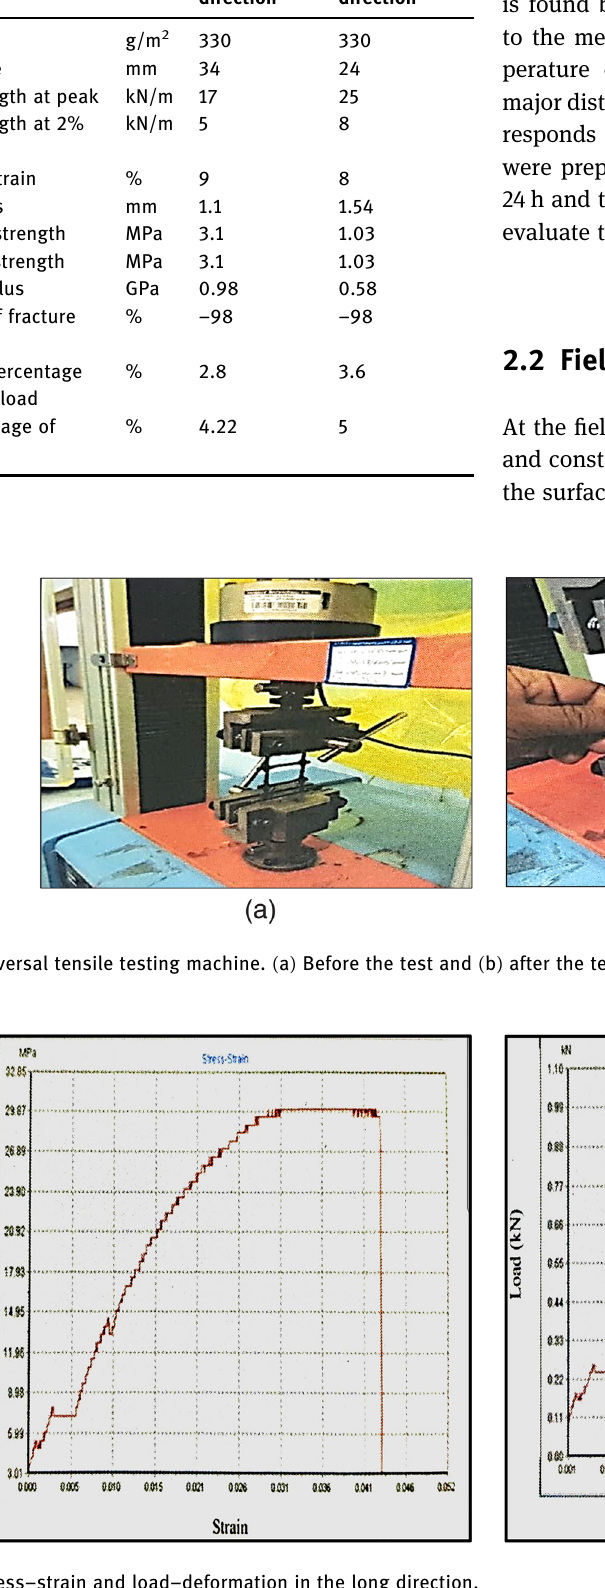
Figure 2: Stress – strain and load – deformation in the long